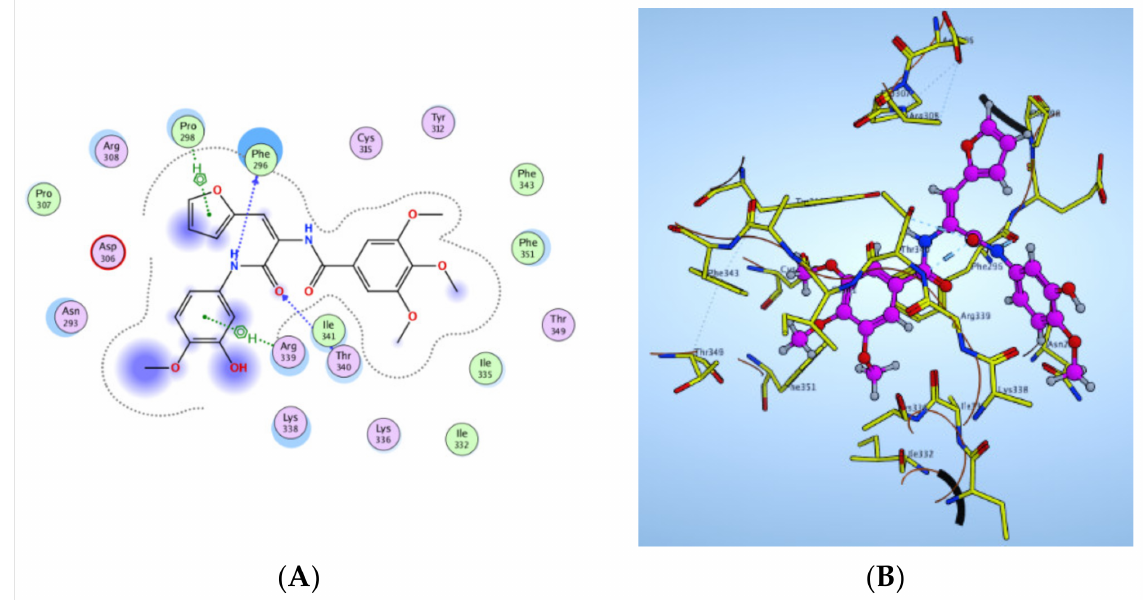
Figure 7. ( A ) Two-dimensional representation of compound 4e docking into the colchicine binding site. ( B ) Three- dimensional representation of compound 4e docking into the colchicine binding